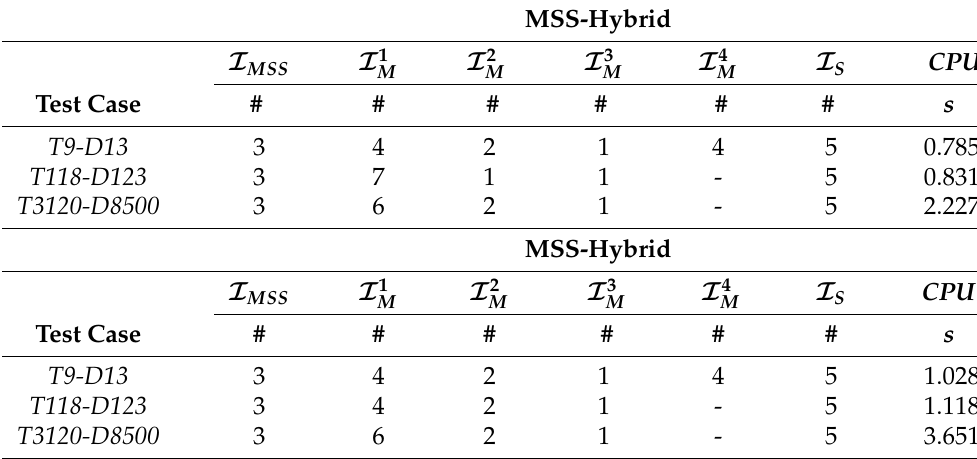
Table 9. The number of master iterations per MSS iteration and the CPU time of the three different test cases when the idea of speeding up the splitting methods is